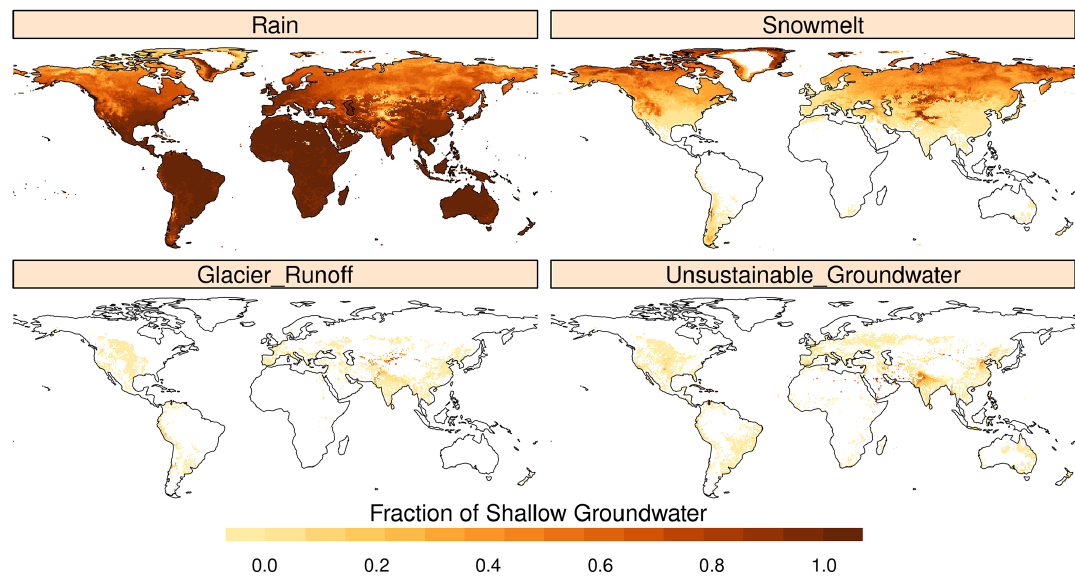
Figure 8. The fraction of average annual shallow groundwater storage composed of the four different primary source water components used in the primary source tracking